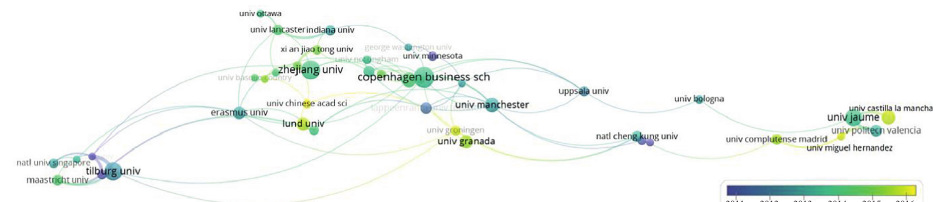
Figure 7: Temporal evolution of institutional networks. Source: own elaboration with Web of Science and Scopus data (2018) processed with VOSviewer software.